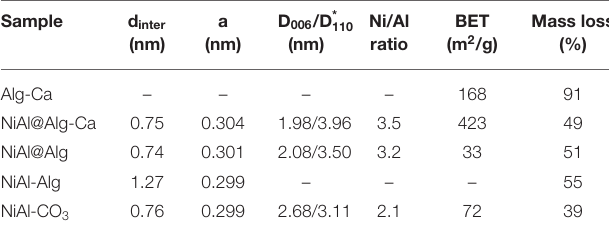
TABLE 1 | Main structural characteristics of the LDH and alginate-based bionanocomposites.